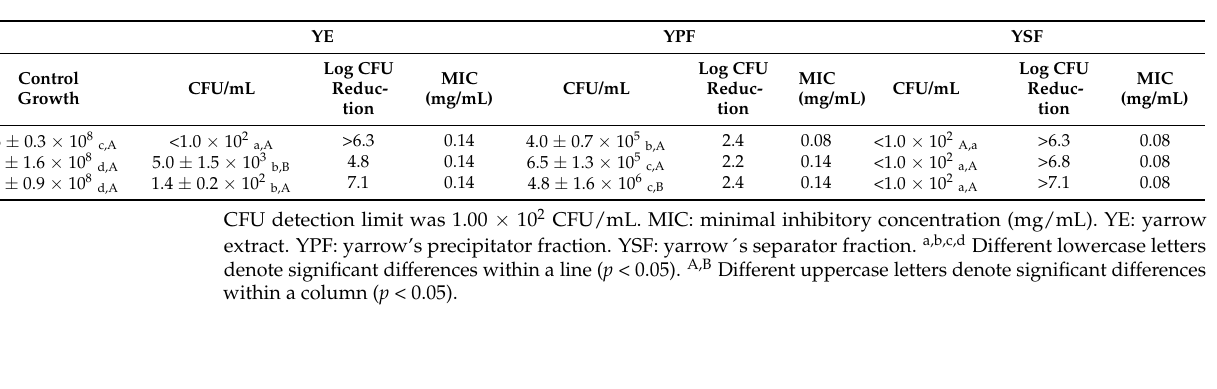
Table 3. Antibacterial activity of YE and its fractions (YPF and YSF) at 0.4 mg/mL against H. pylori strains. Results represent the mean ± standard deviation of colony forming units (CFU)/mL ( n = 3).